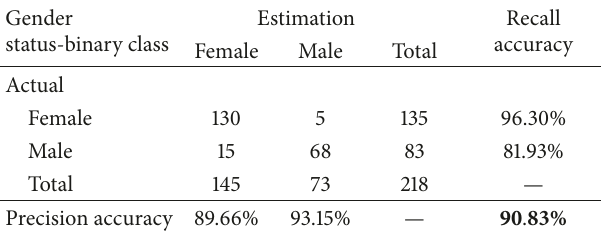
Table 6: Gender multiclass SVM prediction